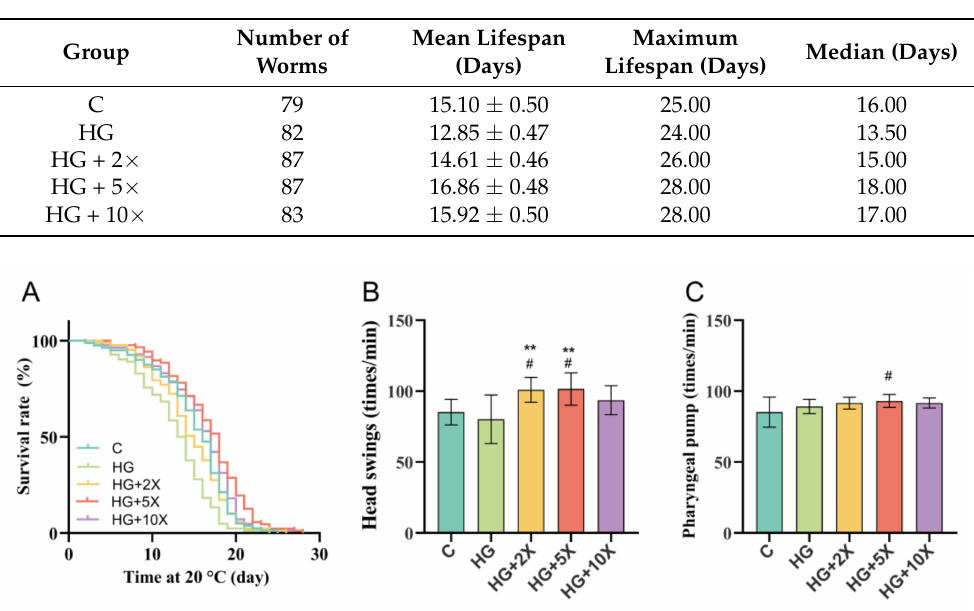
Table 1. Effects of supplementation with A. muciniphila cell-free supernatant on life span in Caenorhabditis elegans .